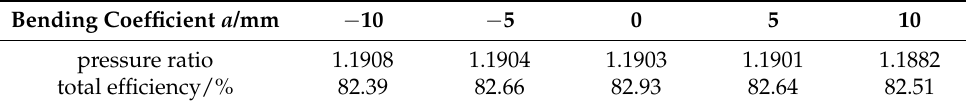
Table 3. Overall aerodynamic performance under the design